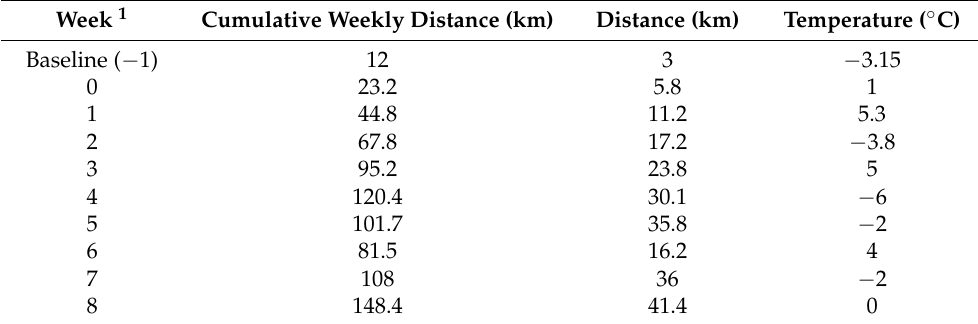
Table 1. Cumulative distance the dogs ran during each week, and distance run and daily temperatures when behavioural observations took